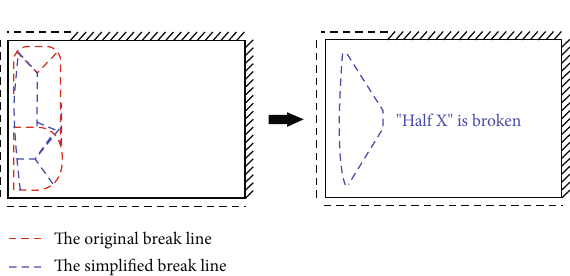
Figure 18: Full-scale mining stope model.